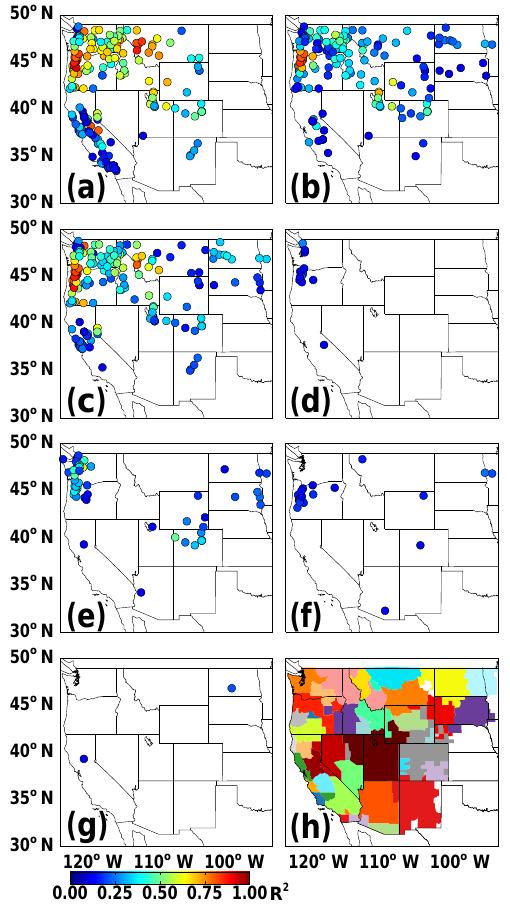
Figure 5. R 2 values at each measurement site for surface measure- ment and Google Trends search for (a) “air quality”, (b) “wild- fire”, (c) “smoke”, (d) “pollution”, (e) “haze”, (f) “smog”, and (g) “ozone.” Only sites where R 2 >0.1 are shown. The 48 DMAs considered are shown in (h)